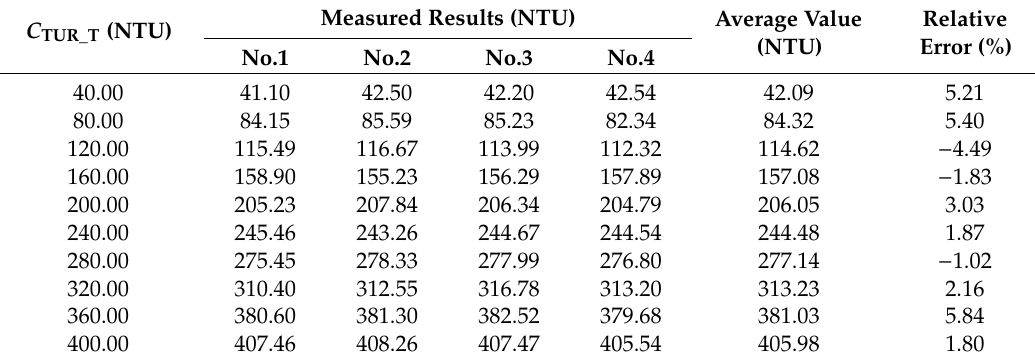
Table 10. Measured results and relative errors for di ff erent concentrations of TURB solution. C TUR_T